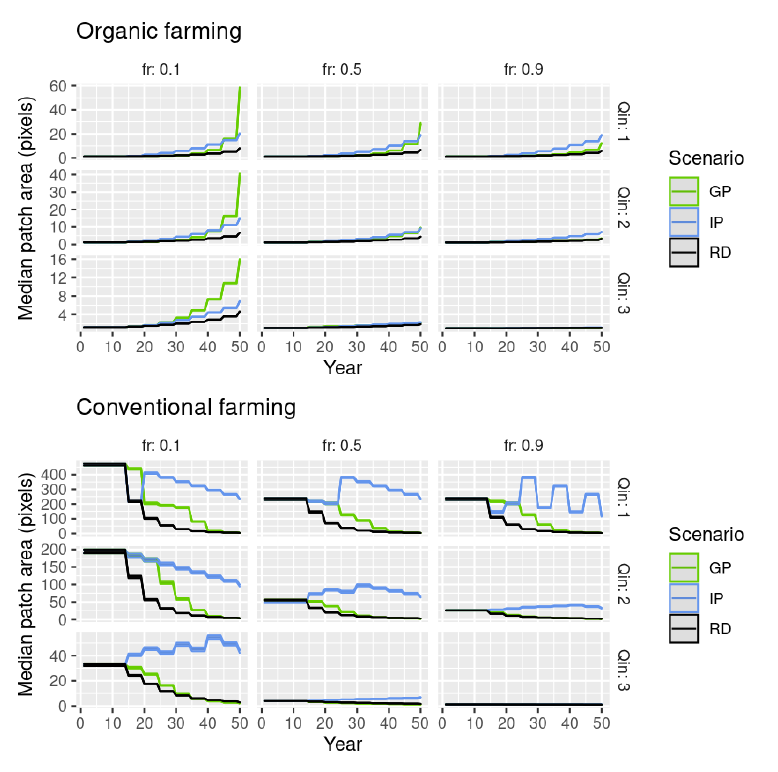
Figure S1.3 . Effects of OF expansion scenarios on the area of organic and conventional patches. Landscape change (median patch area in pixels) during the simulations. The envelope around each curve represents the standard